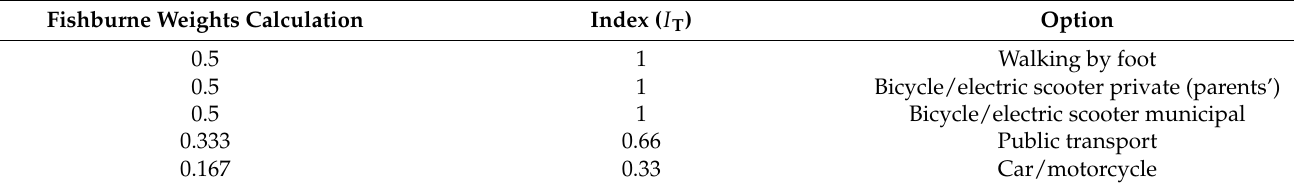
Table 20. Index system for types of transport.